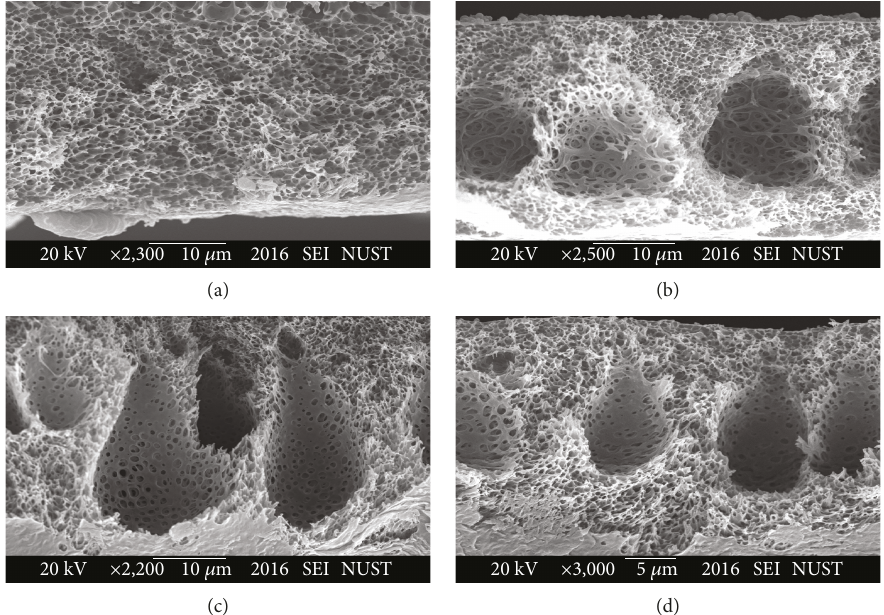
Figure 5: SEM micrographs of fabricated GO-PES membranes showing signi fi cant porosity with increasing GO concentration incorporation in the PES matrix membranes: (a) M1 (pristine PES), (b) M2 with 0.25% GO, (c) M3 with 0.5% GO, and (d) M4 with 1.0%